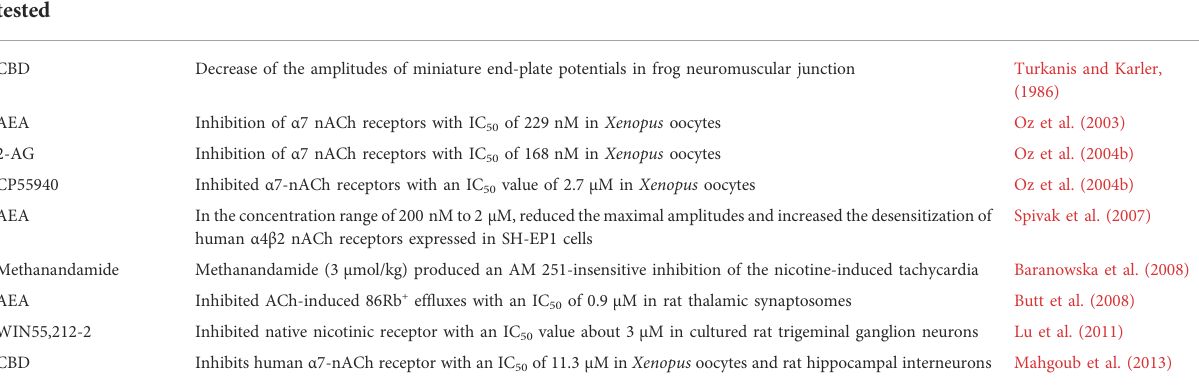
TABLE 1 Effects of cannabinoids on nicotinic acetylcholine receptors. Cannabinoid